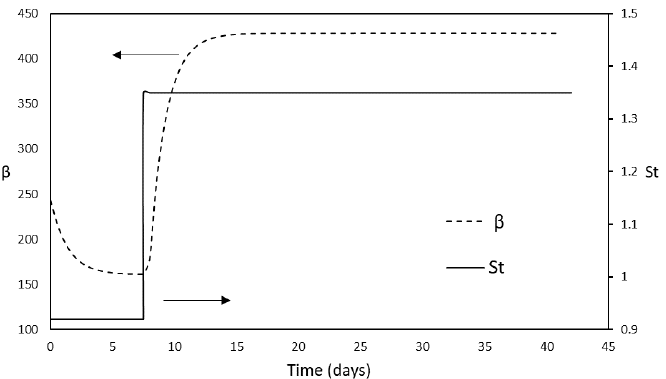
Figure 4. Plot of the dimensionless numbers St (-) and β (–) versus time during the Bio-Methanation working period.